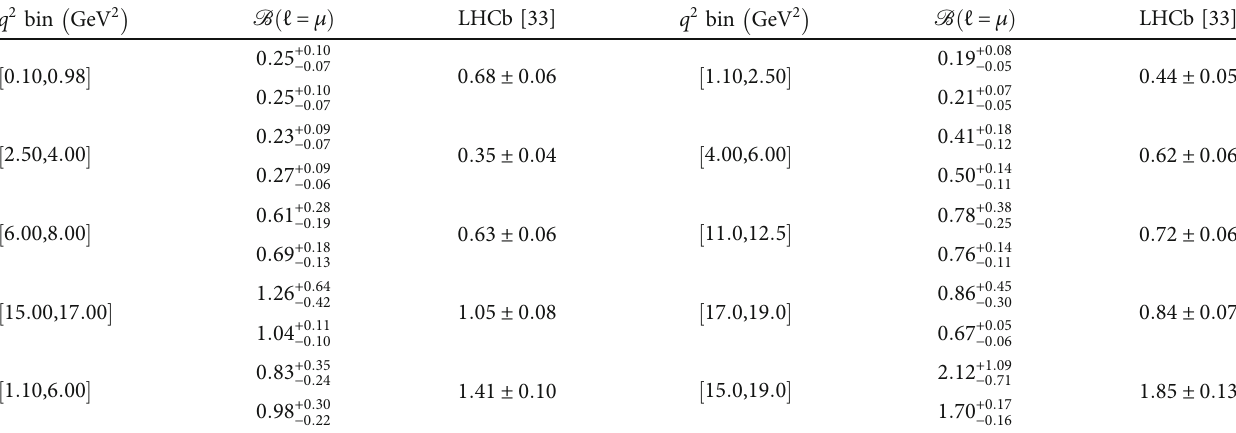
⟶ ϕμ + μ − Þ (in unit of 10 − 7 ) in the PQCD (the fi rst low) and “ PQCD s